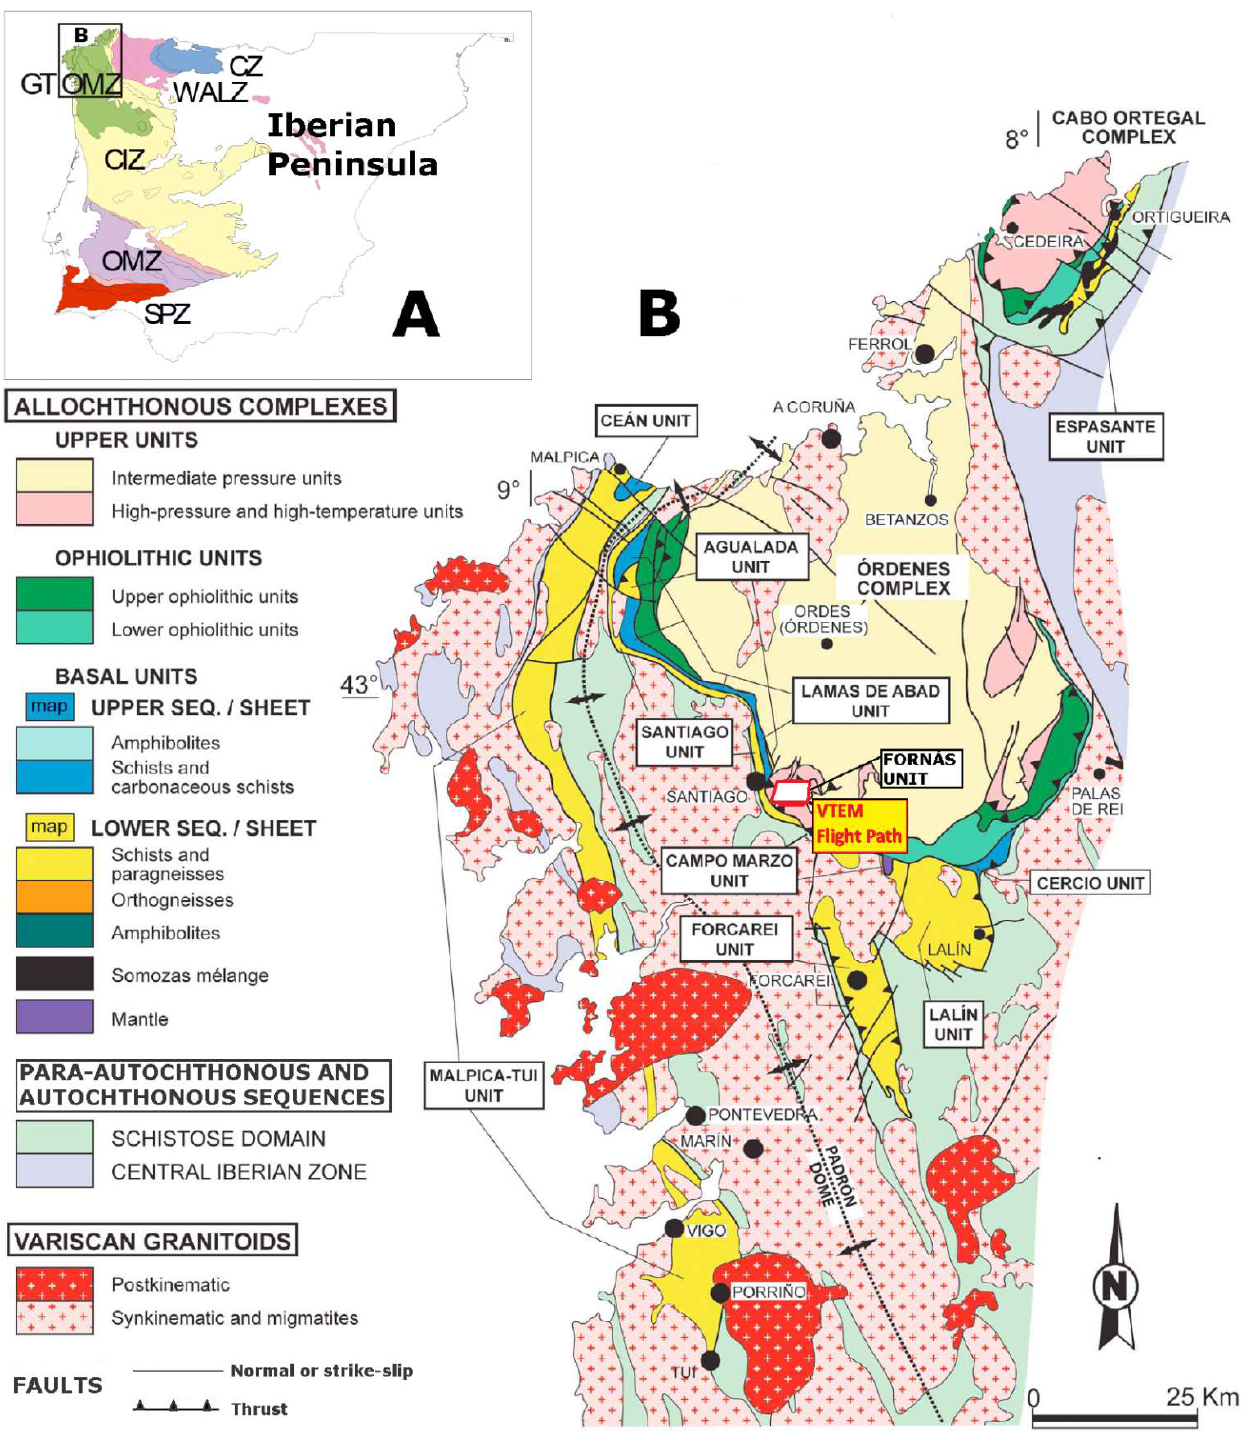
Figure 1. ( A ) Geological sketch of the Iberian Variscan Massif. CZ: Cantabrian Zone, WALZ: West Asturian Leonese Zone, CIZ: Central Iberian Zone, OMZ: Ossa Morena Zone, and SPZ: South Portuguese Zone [25, 26]. ( B ) Geological map of the NW Iberian Variscan Massif showing the location of the Ordenes and Cabo Ortegal allochthonous complexes, as well as units of Galicia-Trás-Os-Montes Zone [26] and the Central Iberian Zone [22].